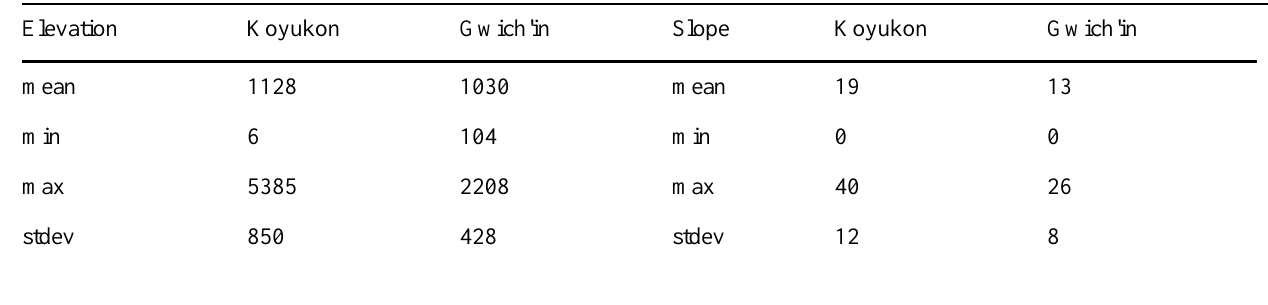
Table 4. Elevation (m) and slope (degree) comparison of Koyukon and Gwich’in territories in Alaska.